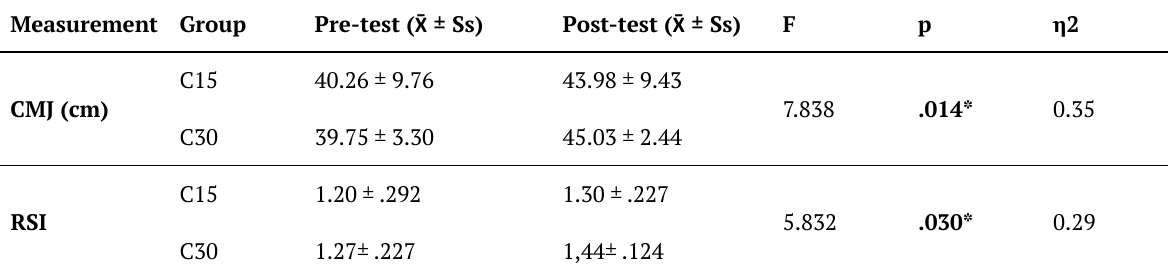
C15: cluster 15sn. intra-set; C30: cluster 15sn. intra-set; CMJ: countermovement jump; RSI: reactive strength index; Cm: centimetre; *Statistically significant differences (P<